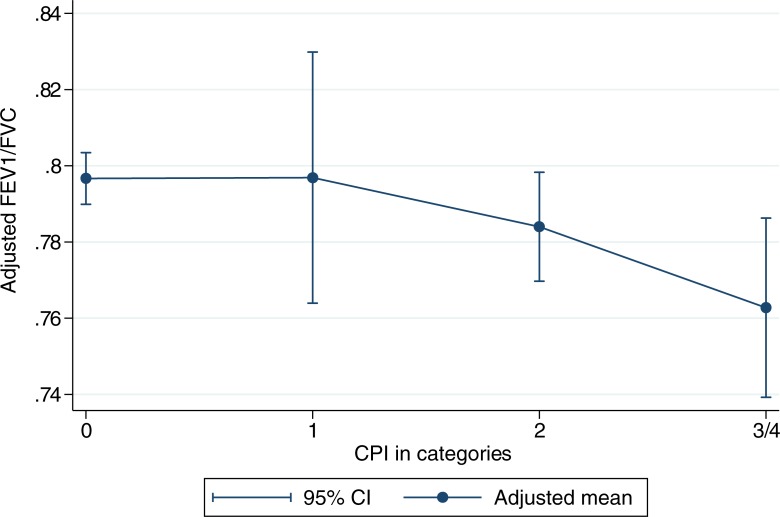
Adjusted FEV1/FVC ratio in categories of CPI with category 3 and 4 combined.Adjusted for age, sex and smoking.